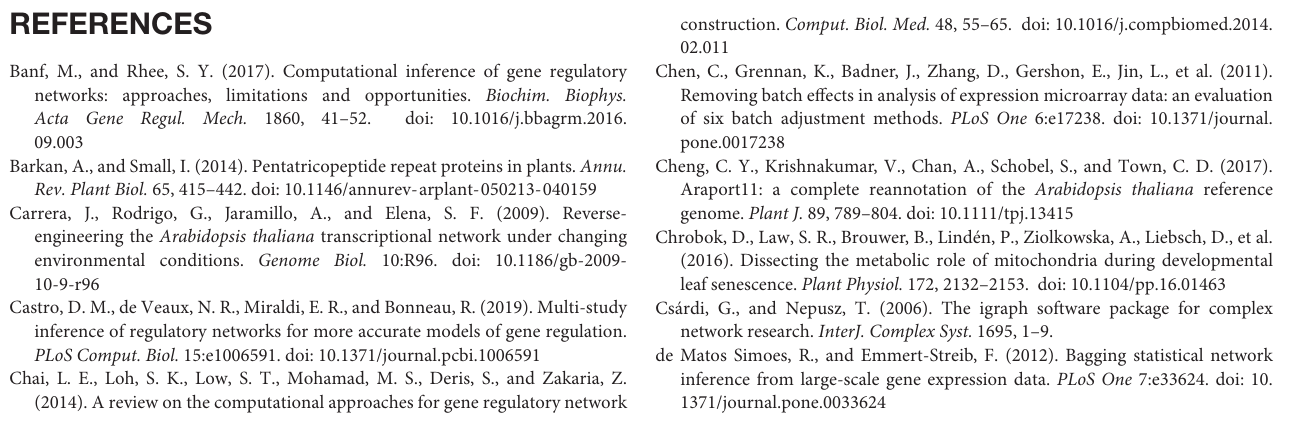
FIGURE S5 | Correlation between the 985 mitochondrion related genes were estimated using Pearson correlation without centralization (Non-Centralized data) and Pearson correlation with CSE preprocessing (CSE preprocessed data). For each approach 484,620 correlations were estimated and the 0.5% (2423) gene correlations with the highest absolute value were used to predict edges in the corresponding gene co-expression network. (A) Estimated density functions over all estimated correlations for non-centralized data (green) and CSE preprocessed data (red). The black line shows the density for correlations estimated on simulated noise. (B) The estimated correlations for the two approaches plotted against each other. Edges shared by both approaches are marked blue (620 (25.6%) of the edges were shared), unique edges for the CSE preprocessing network are marked red, and unique edges for the Non-centralized network are marked green. TABLE S1 | List of 984 genes encoding proteins targeted to the mitochondrion, referenced with the AtGenExpress Expression Atlas (Schmid et al., 2005; Kilian et al., 2007; Goda et al., 2008). Note that dues to its large size (ca. 250 MB), the file is available at: https://www.upsc.se/documents/olivier/Supplemental_Table_1_